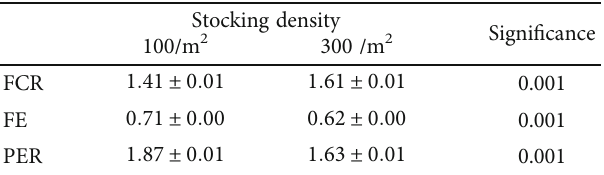
Table 4: Feed utilization parameters for whiteleg shrimp L. Vannamei reared under di ff erent density bio fl oc systems for 135 days.